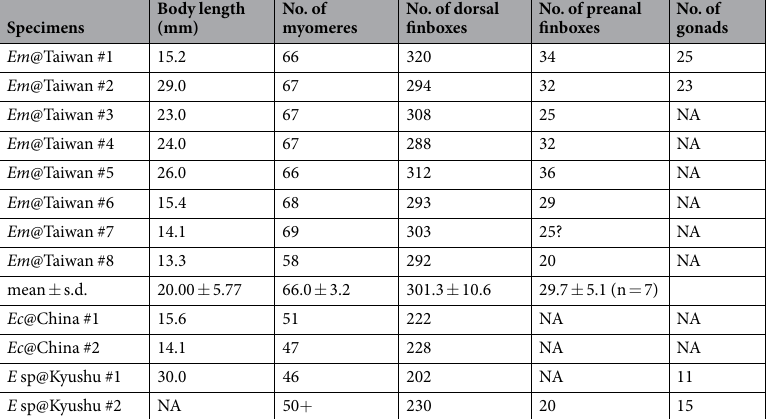
Table 1. Metrical characteristics of Epigonichthys species from China-Taiwan-Japan waters. Em , assigned to Epigonichthys maldivensis 16 ; Ec , assigned to E. cultellus 17 . Mean ± s.d. with blue highlight is for E. maldivensis from Nanwan Bay,